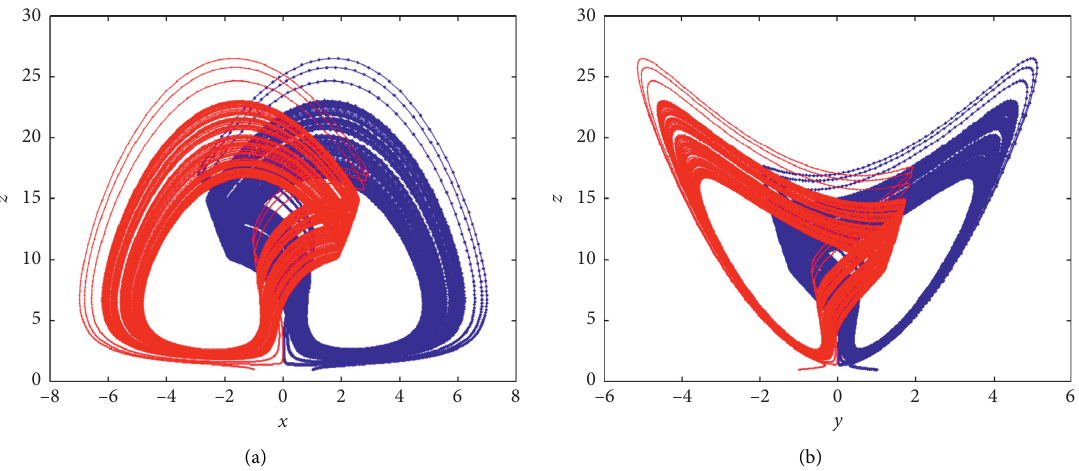
Figure 25: Coexisting attractors in ( x, z )( y,z ) planes at α � 0 . 995.